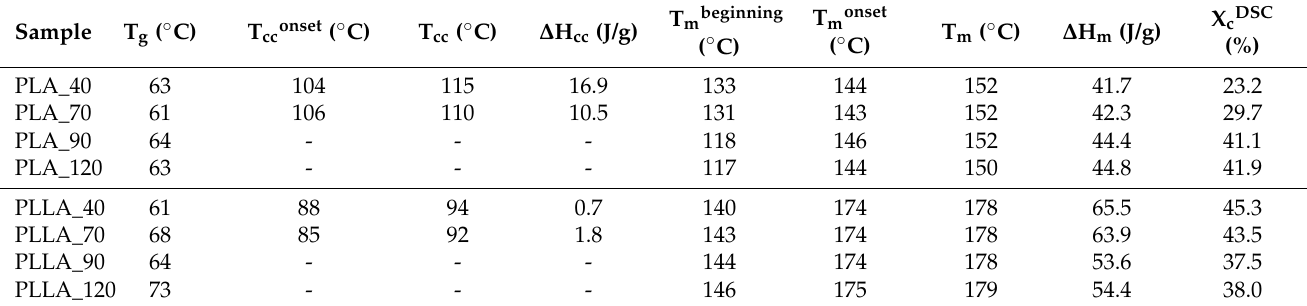
Table 3. Thermal parameters of PLA and PLLA microspheres annealed at 40, 70, 90, and 120 ◦ C.